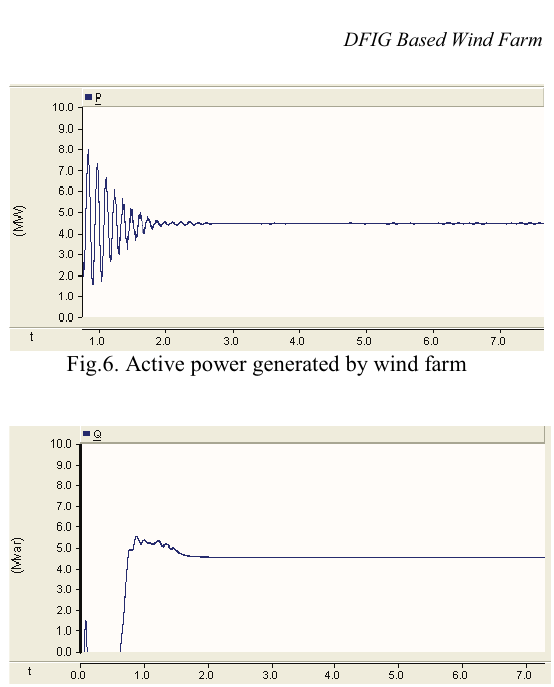
Fig.7. Reactive power generated by wind